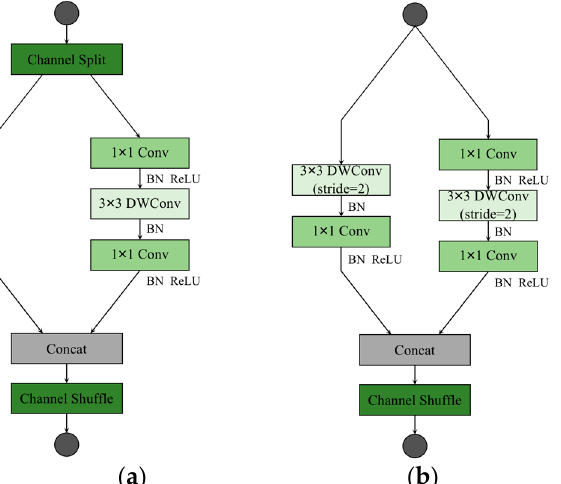
Figure 2. Building blocks of ShuffleNetv2. ( a ) The basic unit; ( b ) the spatial downsampling unit. DWConv denotes depthwise convolution.